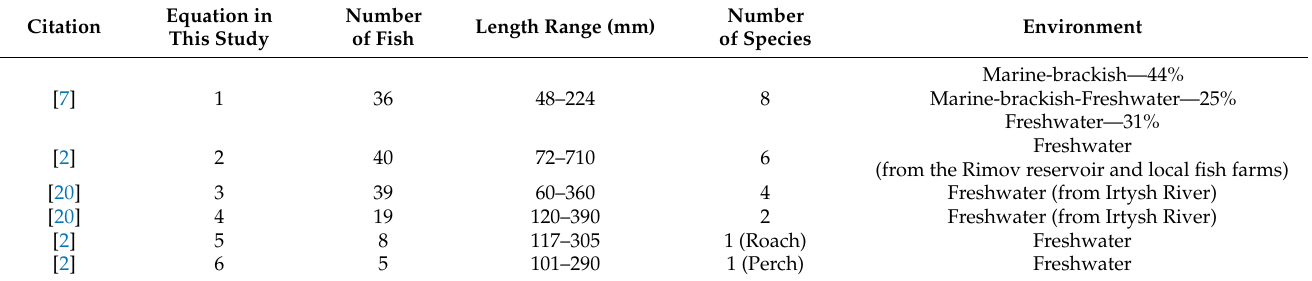
Table 4. Ranges of total length (TL), number of fish, number of investigated species, and their environment in the study of the relationship between target strength (TS) and total length (TL) of